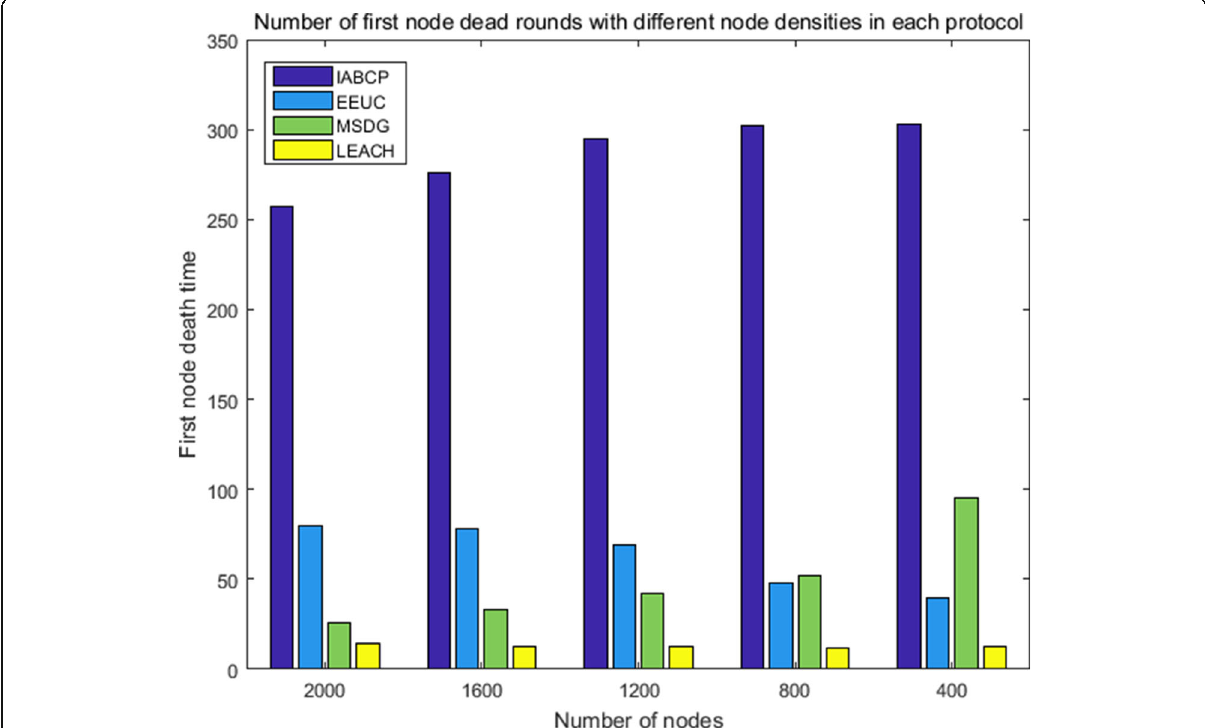
Fig. 12 Number of first node dead rounds with different node densities in each protocol. In order to prove the wide applicability of this protocol, the simulation of the number of the first dead node turns is carried out in the equal area under different node